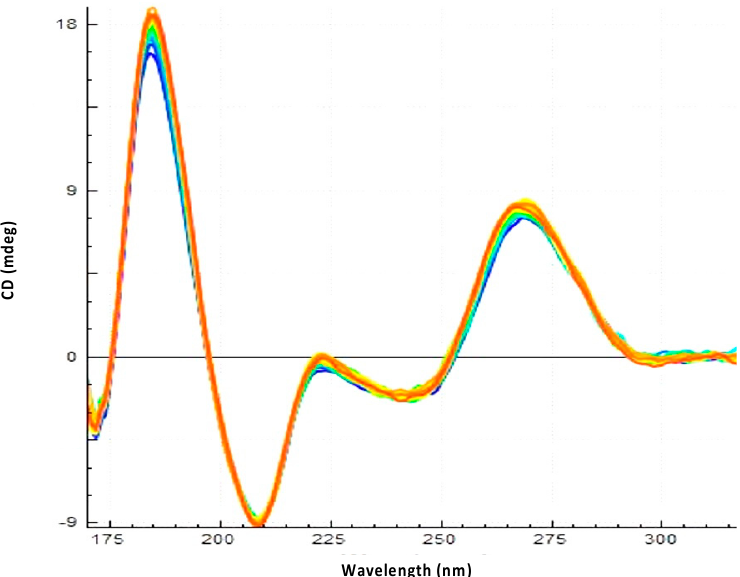
Figure 6. Effect of Hfq-CTR on DsrA coremut spectral evolution. In this case no significant stabilization is observed. Note the amplitude of 18 mdeg measured at 180 nm. As DsrA core (Figure 5) and DsrA coremut were used at the same concentration and pathlength, this confirms that DsrA coremut has a stronger (3-fold) structuration than DsrA core . This was expected due to the presence of the structured tetraloop.